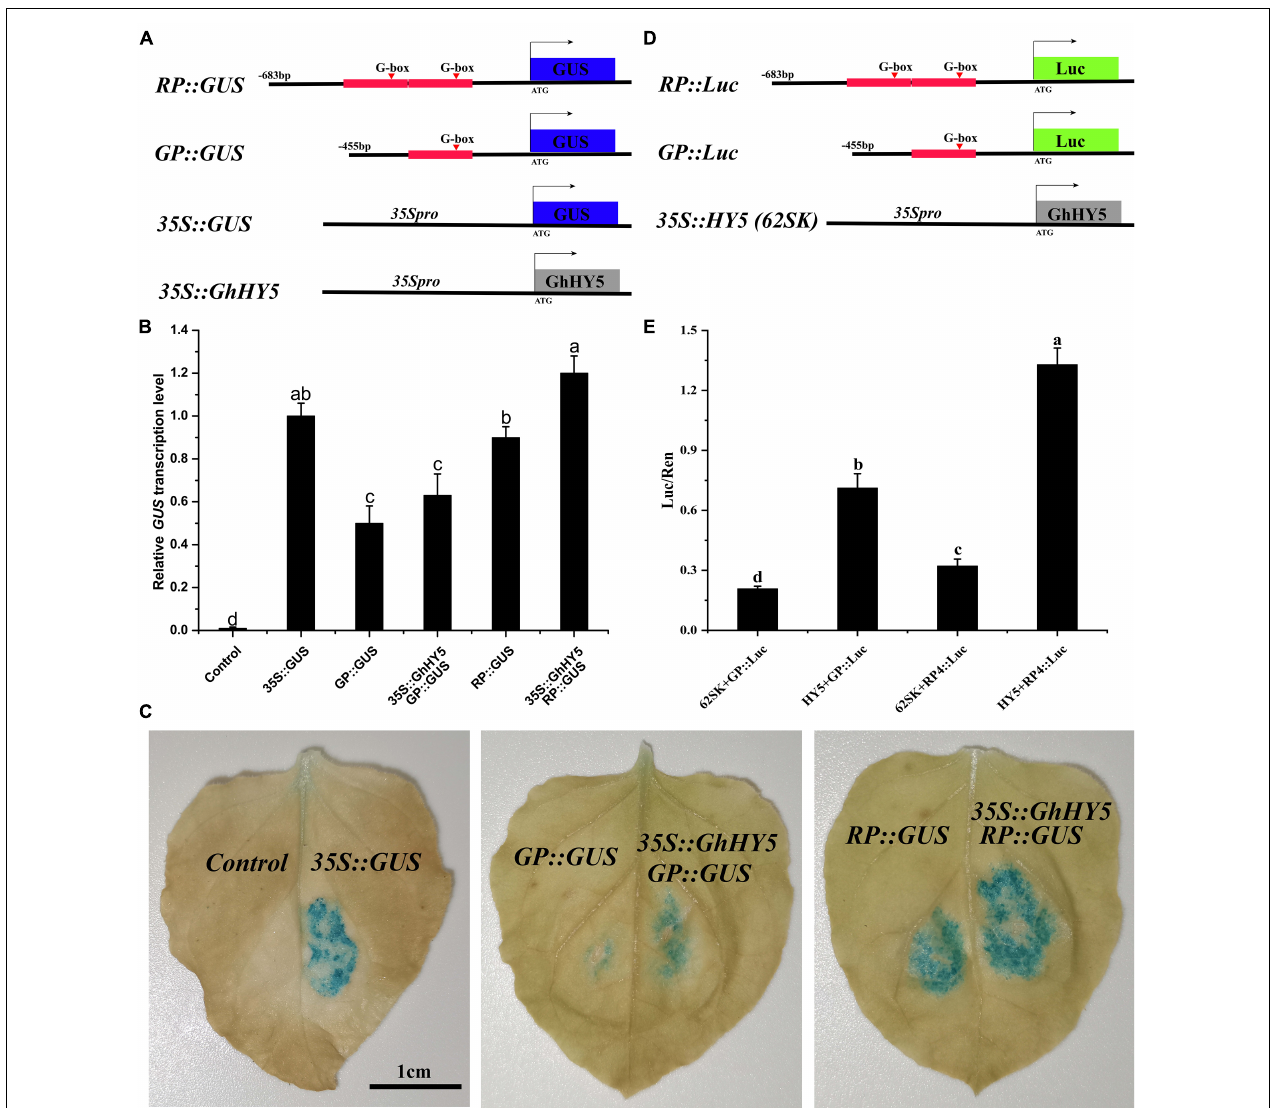
FIGURE 8 | GhHY5 act as a cis -regulator of GhPAP1D expression. (A) Schematic diagram of constructs used in GUS experiment. (B) qRT-PCR analysis was conduct to detect GUS expression using three biological replicates. (C) GUS staining of 35S:GUS , GP:GUS , RP:GUS , GP:GUS plus 35S:GhHY5 , and RP:GUS plus 35S:GhHY5 . (D) Schematic diagram of constructs used in the luciferase reporter assay. (E) Effects of GhHY5 on the activity of RP and GP promoters of GhPAP1D in luciferase assays. The ratio of Luc/Ren of the empty vector (62SK) plus promoter was used as the control. Different letters denote significant differences according to one-way analysis of variance (ANOVA) ( P <